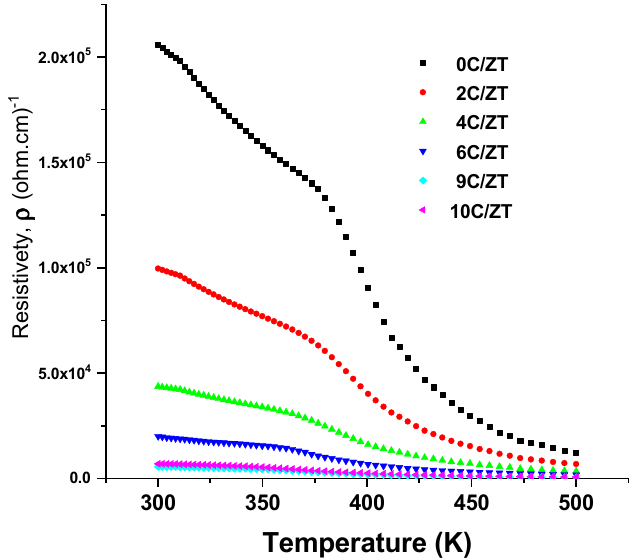
Figure 13. The resistivity ρ versus temperature of the undoped and Cu-doped ZnTe films.